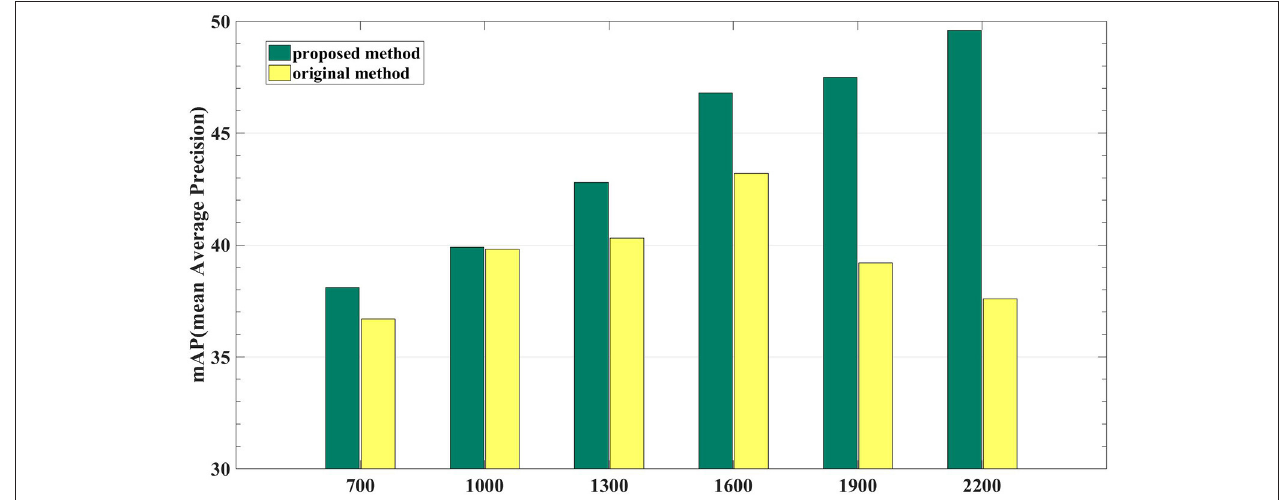
FIGURE 7 | The comparison results of mAP before and after optimization using focal loss under different data volumes.